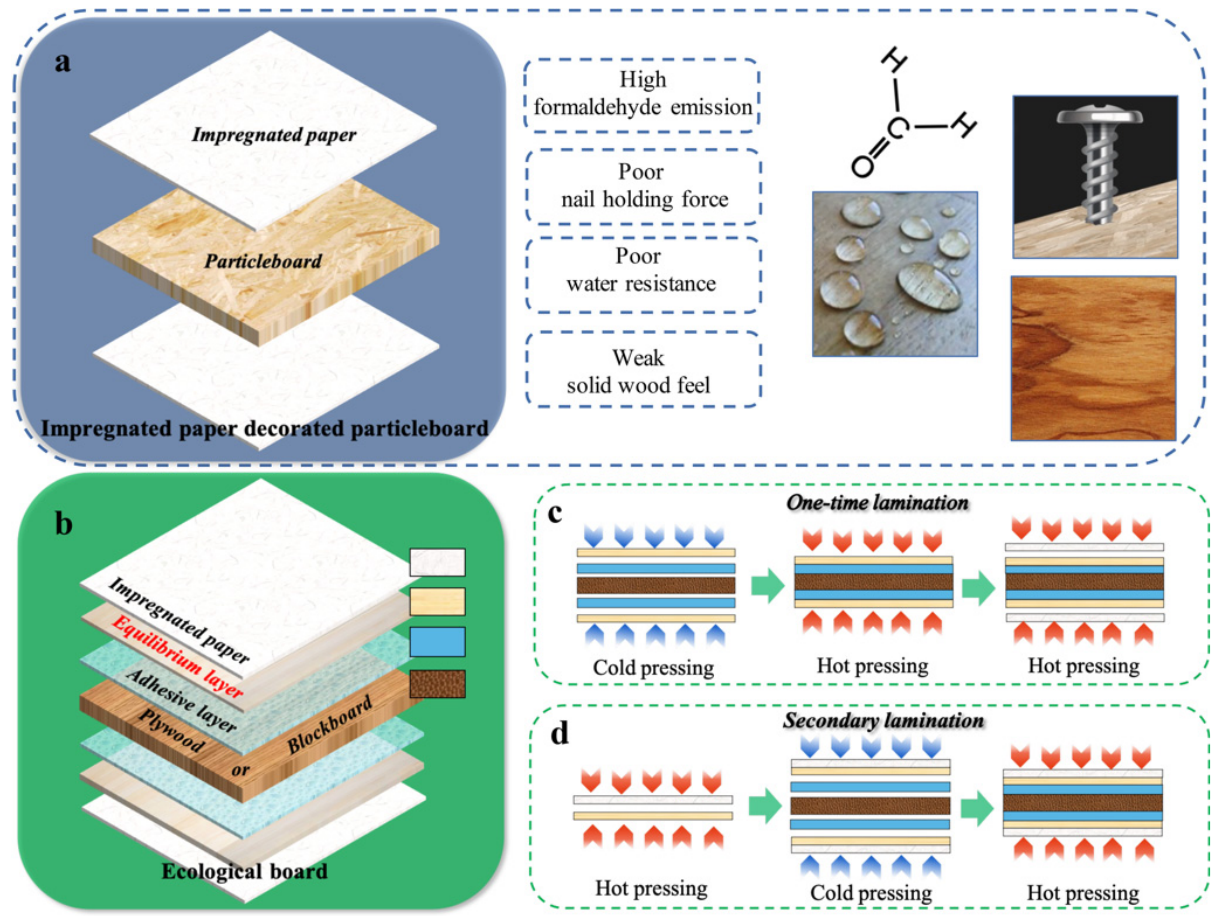
Figure 1. Impregnated paper decorated wood-based panels. ( a ) Structure of impregnated paper decorated particleboard; ( b ) Structure of ecological board; ( c ) One-time lamination method; ( d ) Secondary lamination method.